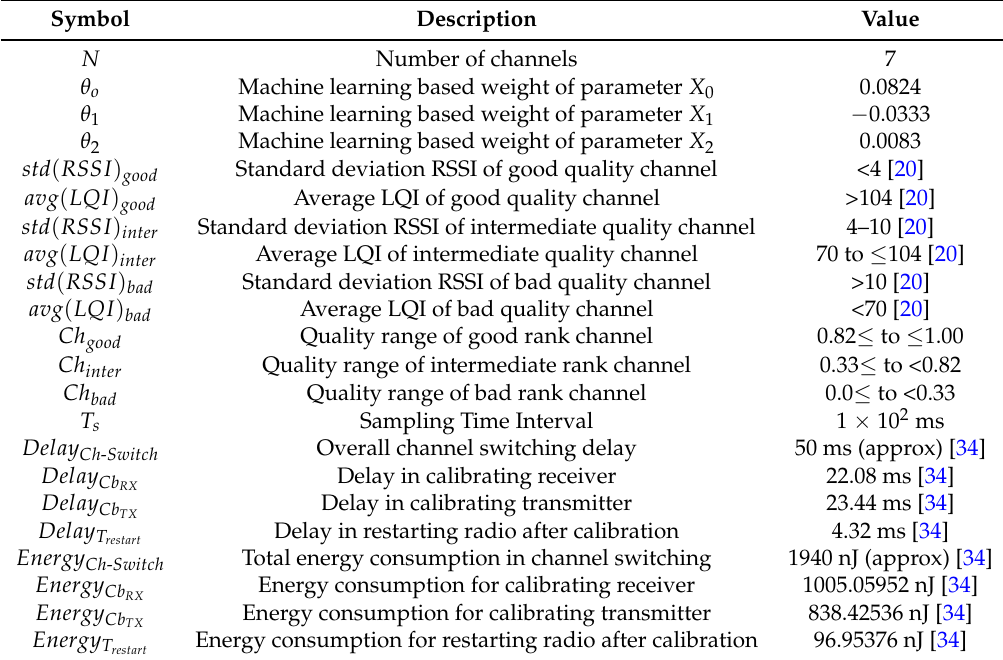
Table 6. Simulation